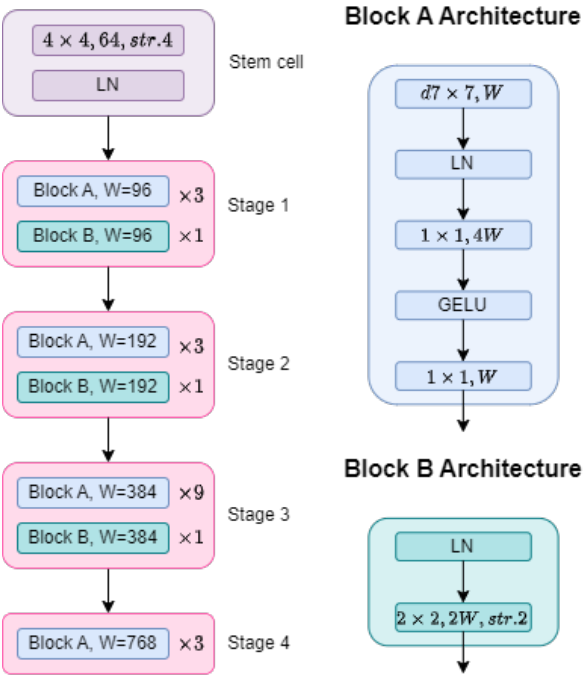
Figure 3. ConvNeXt architecture. The left part of the figure shows the general connection of the three hierarchical entities: stages, blocks, and layers. The right part of the figure represents the composition of a single block into